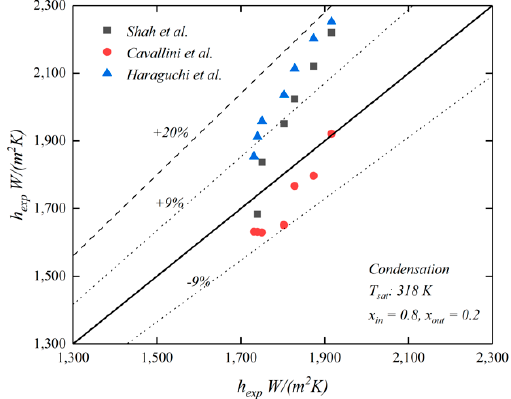
Figure 4. Comparison of condensation correlations for use with smooth tubes.